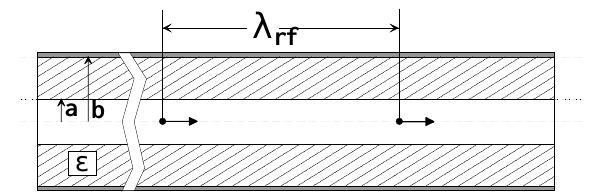
FIG. 1. The multimode waveguide driven by a bunch train (two bunches, separated by l rf , shown). The thick walled dielectric waveguide has inner radius a (cid:1) 0.5 cm, outer ra- dius b (cid:1) 1.44 cm, length L (cid:1) 60 cm, and dielectric constant ´ (cid:1) 38.1